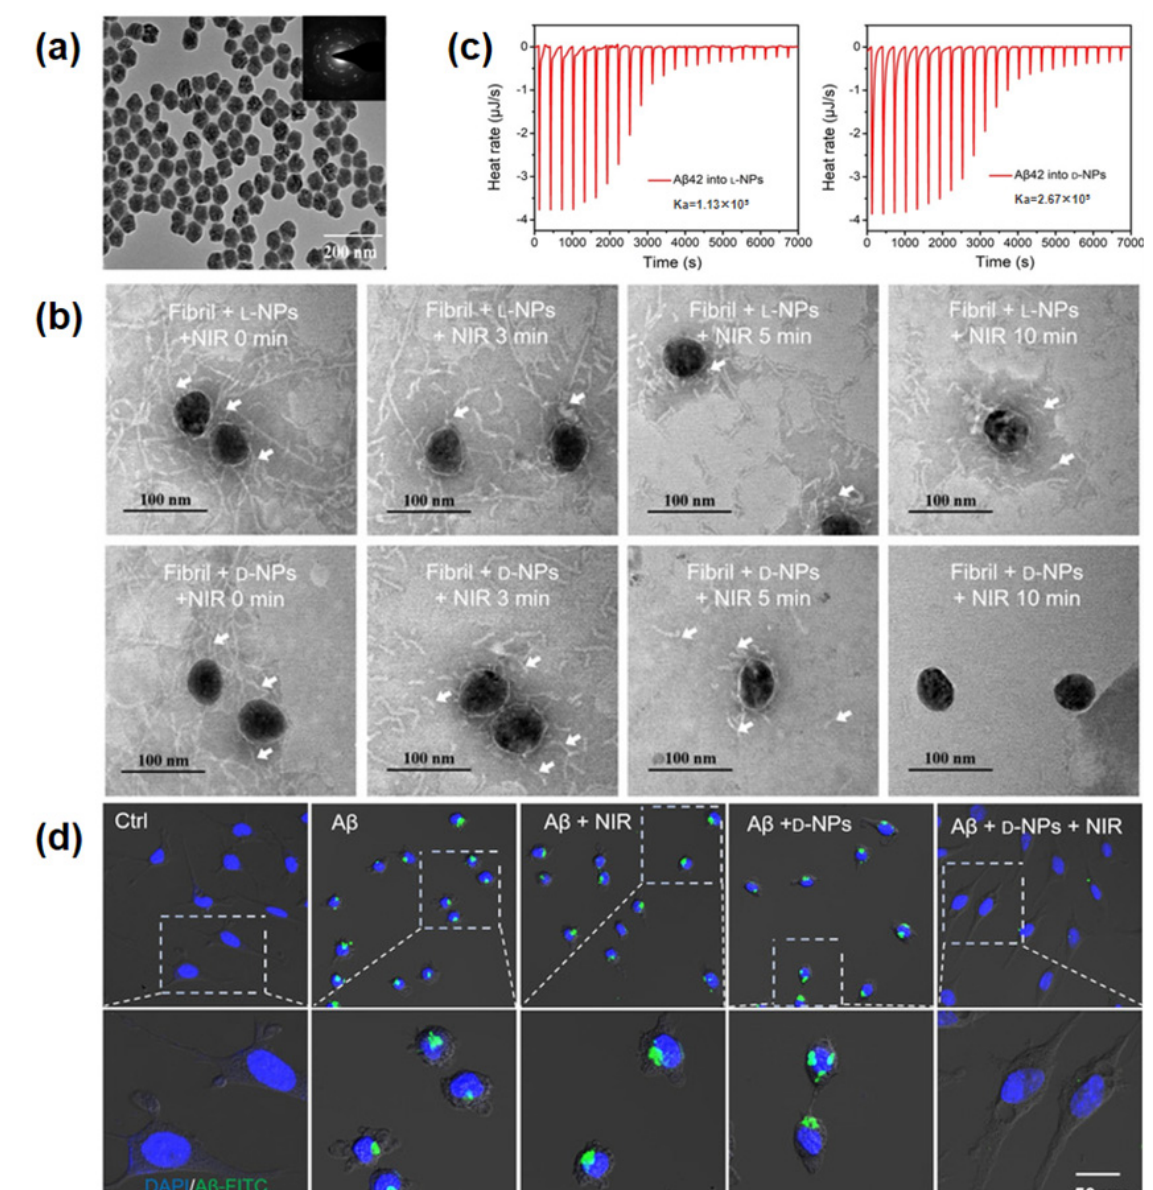
Figure 4. ( a ) TEM image and selected area electron diffraction pattern of chiral Fe x Cu y Se NPs. ( b ) TEM images of preformed A β 42 fibrils at different times (0, 3, 5 and 10 min) of treatment with L- / D- NPs and NIR irradiation. Arrows indicate A β 42 fibrils ( c ) ITC experiments for L- and D- NPs in A β 42 protein solution. ( d ) Confocal images showing A β 42 (green) adhesion onto the membranes of MN9D cells treated with NIR, D- NPs, as well as D- NPs and NIR. Nuclei were stained with DAPI (blue). Reprinted with permission from Ref. [26]. Copyright 2020 John Wiley and